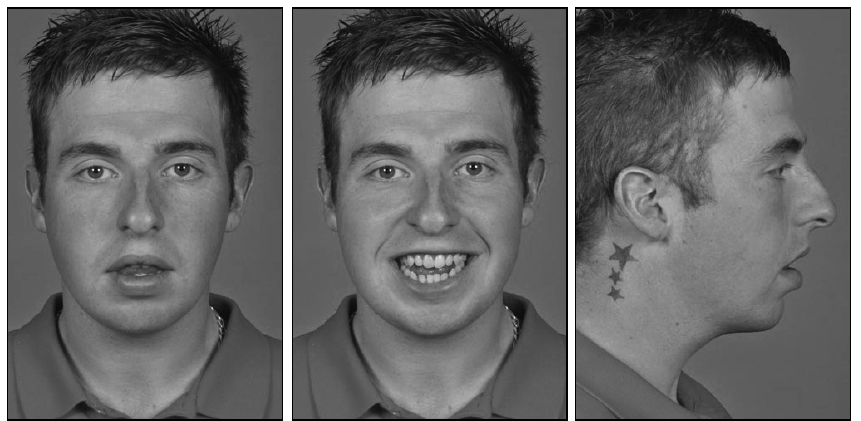
Figure 1. Pretreatment facial views. Frontal view with lips (A) at rest and (B) on smiling. (C) Profile view with lips at